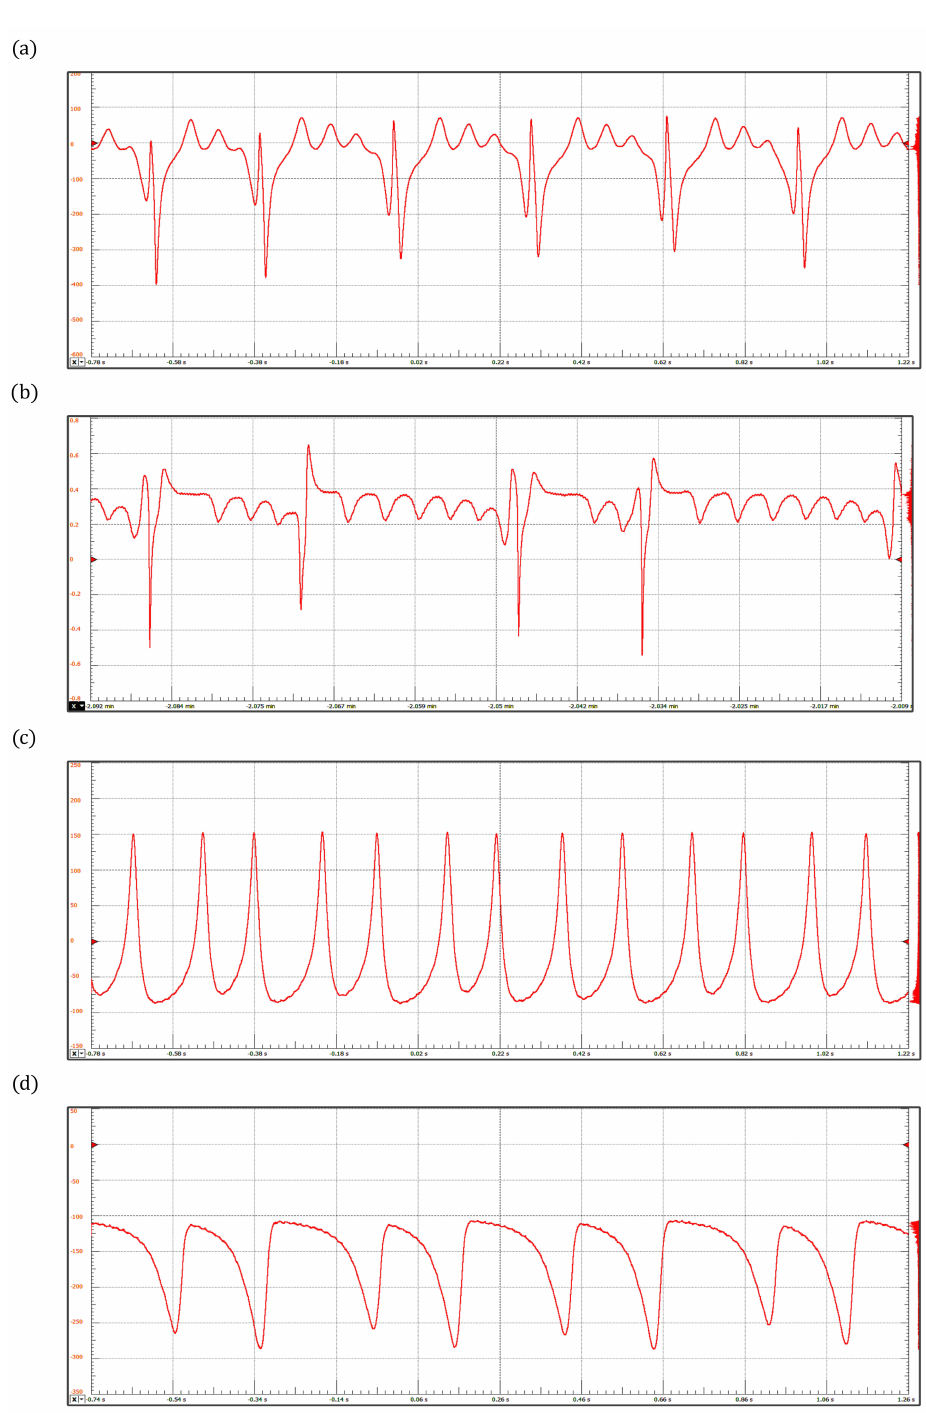
Figure 6. ECG waveforms obtained with the reaction-diffusion model: ( a ) Sinus Tachycardia, ( b ) Atrial Flutter, ( c ) Ventricular Tachycardia, and ( d ) Ventricular